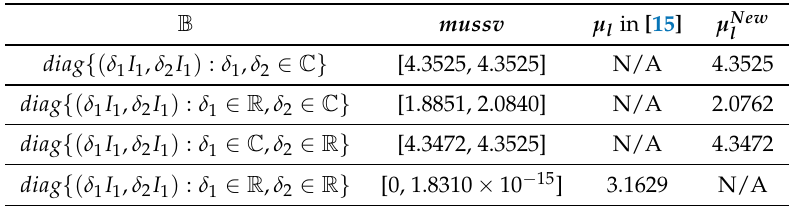
Table 1. Numerical approximation of bounds of structured singular values